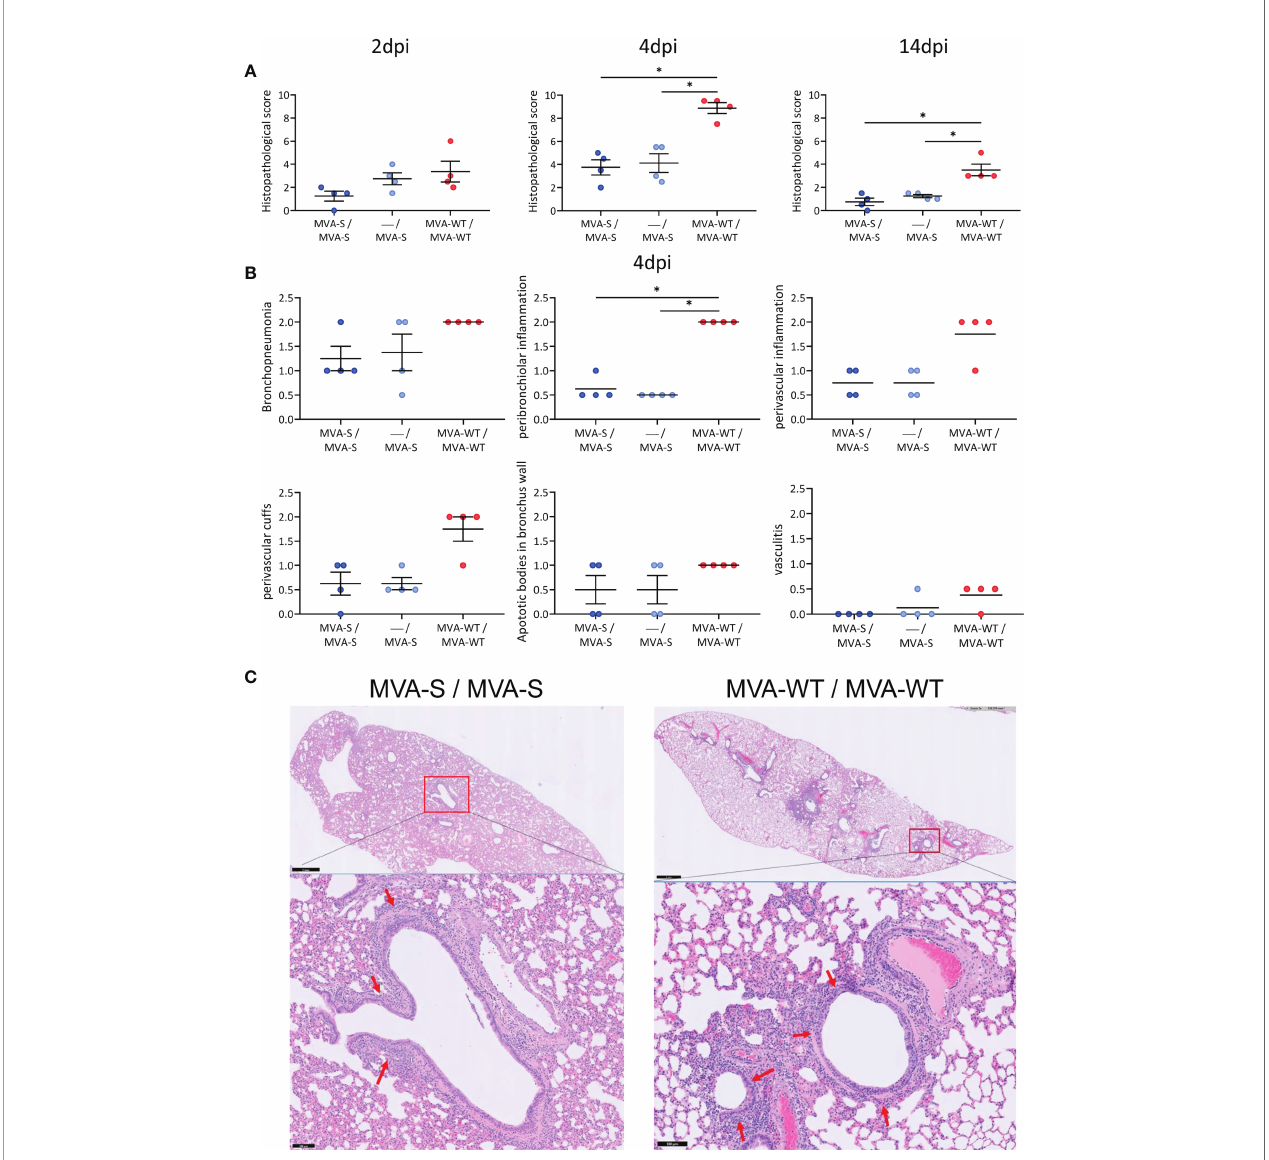
FIGURE 3 | Lung histopathology. (A) Histopathological scores of hematoxylin and eosin-stained hamster lung sections on 2, 4, and 14 days post-infection (dpi). Data presented as means ± SEM. Statistical signi fi cance between groups was calculated by Mann – Whitney test (*p < 0.05). (B) Histopathological scores of day 4 post-challenge are plotted per histopathological sign. Statistical signi fi cance between groups was calculated by Mann – Whitney test (*p < 0.05). (C) Representative hematoxylin and eosin-stained images of lung sections from hamsters at day 4 after virus challenge. General view of the lung (upper) along with histopathological details from selected lung areas (red boxes) have been displayed (lower). Lung sections from vaccinated MVA-S/MVA-S and MVA-WT/MVA-WT control hamsters are represented. Red arrows (lower panel) indicate peribronchiolar in fl ammation. Scale bars: 1 mm (upper) and 100 µm